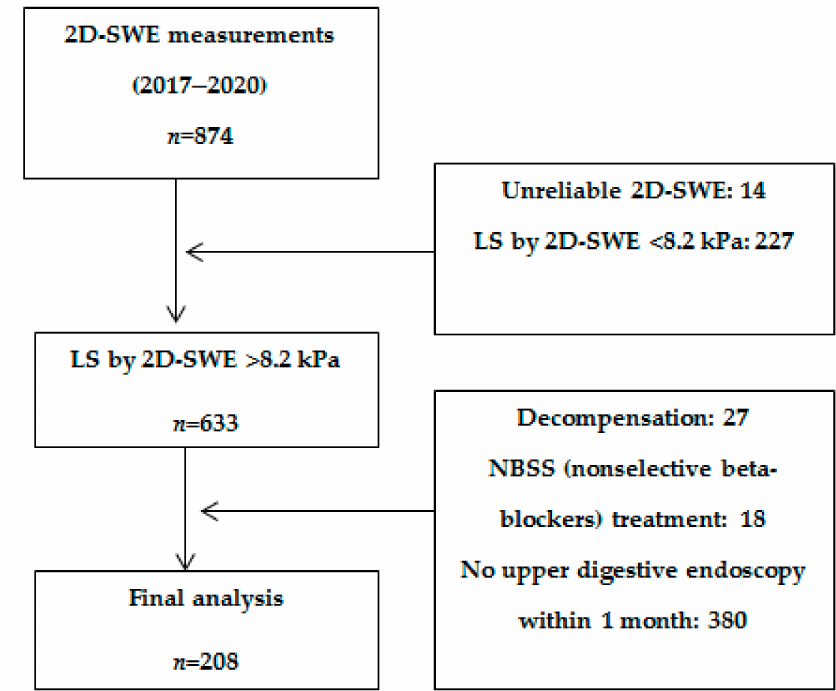
Figure 1. Flow chart of patient